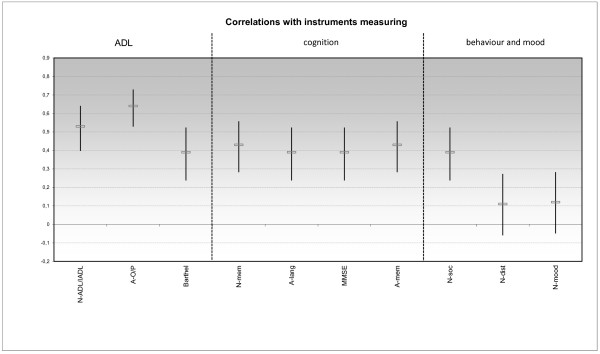
Correlation coefficients of the E-ADL-Test with other procedures (with confidence intervals). N-ADL/IADL: combined subscales of the NOSGER on ADL and IADL. A-O/P: subscale Orientation/Practice of the ADAS-cog. N-mem: subscale Memory of the NOSGER. A-lang: subscale Language of the ADAS-cog. A-mem: subscale Memory of the ADAS-cog. N-soc: subscale Social behaviour of the NOSGER. N-dist: subscale Disturbing behaviour of the NOSGER. N-mood: subscale Mood of the NOSGER.